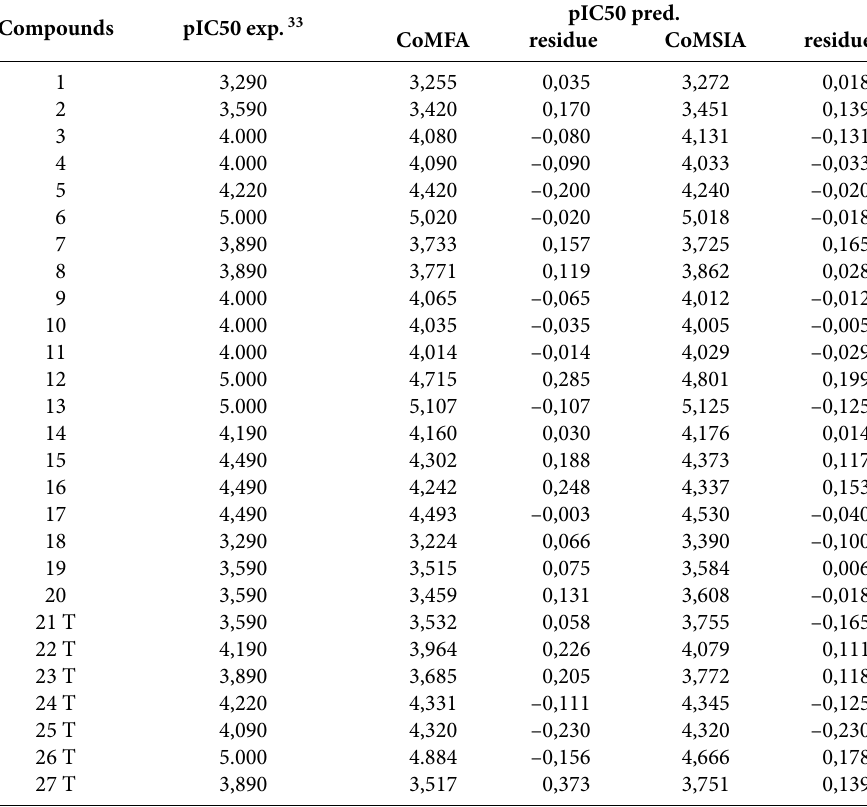
Table 2. Experimental and calculated activity (pIC50) for staphylococcus aureus inhibitors of set training and test set for the CoMFA and CoMSIA models. Compounds pIC50 exp.